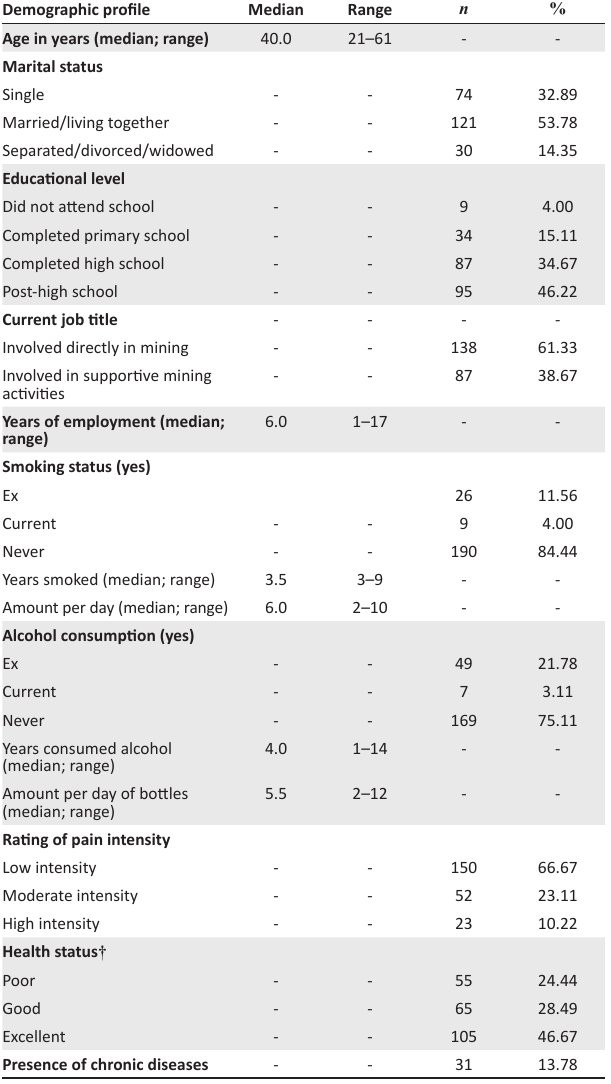
TABLE 1: Demographic profile and health status of female miners in a South African gold mine in 2017 ( n = 225). Demographic profile